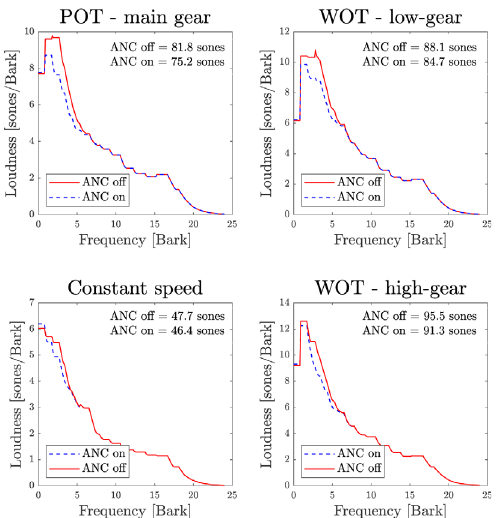
Figure 14. Speci fi c loudness trend calculated according to the ISO 532-1 during the analysed manoeuvres, averaged over the 4 error microphone locations. The bottom left box indicates the overall loudness values calculated in the two conditions – solid red line ANC off, dashed blue line ANC